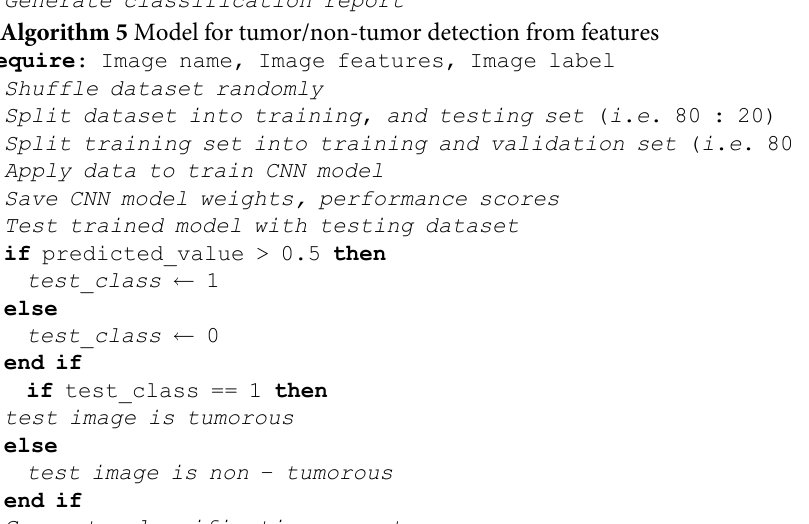
Algorithm 5 Model for tumor/non-tumor detection from